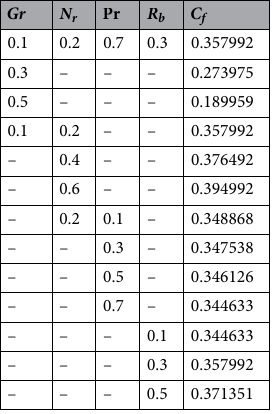
Table 1. The skin friction parameter estimated at y = h with the variations of Gr , N r , R b , and Pr